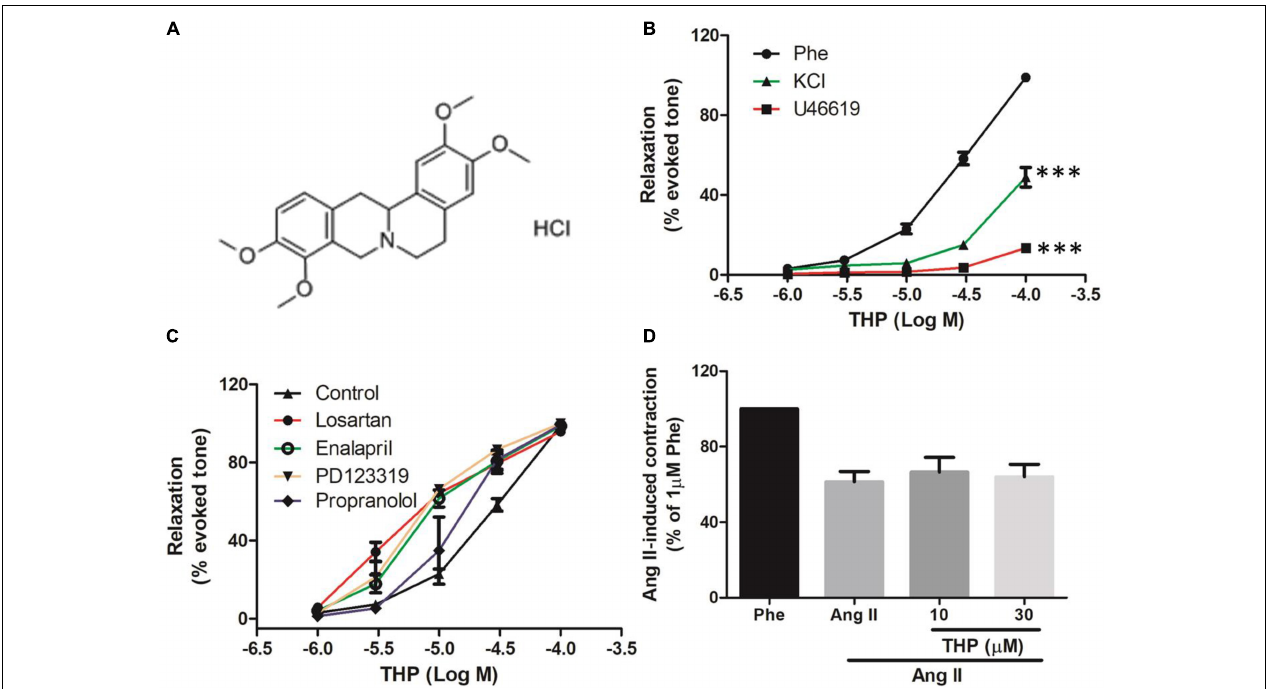
FIGURE 1 | Tetrahydropalmatine (THP) induced vascular relaxation in rat aorta. (A) The chemical structure of Tetrahydropalmatine Hydrochloride (THP, PubChem CID: 6602555). (B) Rat aortic rings were pre-contracted by phenylephrine (Phe, 1 µ M), U46619 (30 nM), or KCl (60 mM) and various concentration of THP (1, 3, 10, 30, and 100 µ M) were cumulative applied to induce vascular relaxation. (C) Aortic rings were pre-incubated propranolol (1 µ M), Losartan (1 µ M), Enalapril (1 µ M), or PD123319 (1 µ M) for 30 min followed by the addition of Phe (1 µ M) to induce contraction and relaxed by cumulative addition of THP (1, 3, 10, 30, and 100 µ M). (D) Aorta rings were pre-incubated THP (10 and 30 µ M) for 30 min then followed by the addition of Ang II (3 µ M) to induce vascular contraction. Vascular relaxations or contractions were presented as percentage of the evoked tone. Results were means ± SEM. ∗∗∗ P < 0.001 versus control